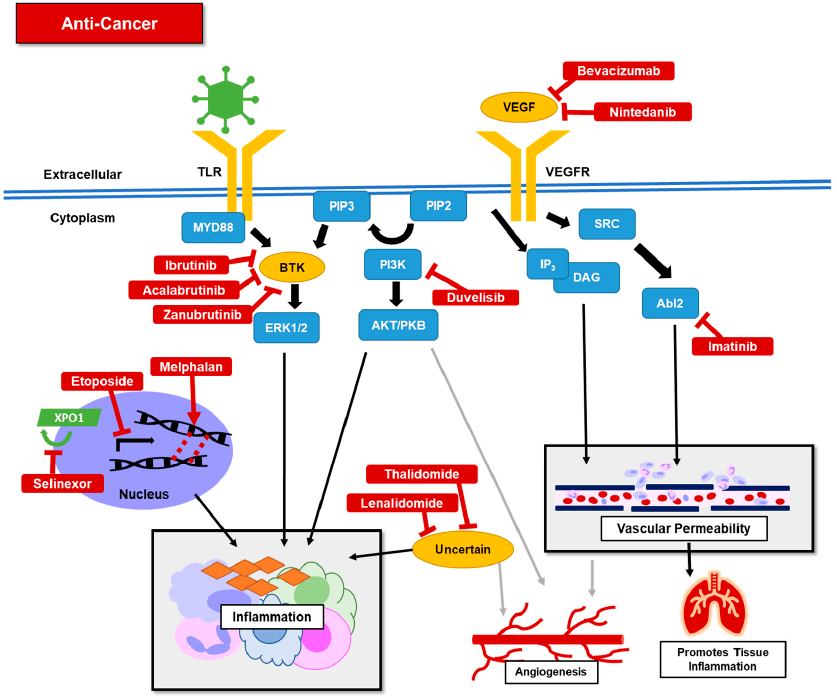
Figure 5. Schematic represents potential mechanisms of anti-cancer therapies (solid red) under investigation to treat COVID-19 related inflammation through decreasing inflammatory response and reducing vascular